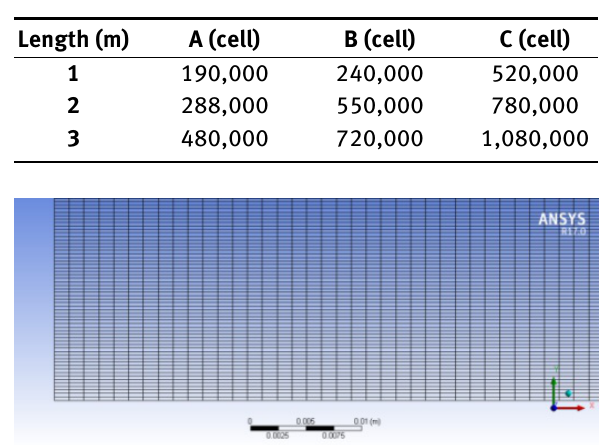
Table 2: Mesh sizes, the oil inlet from the center